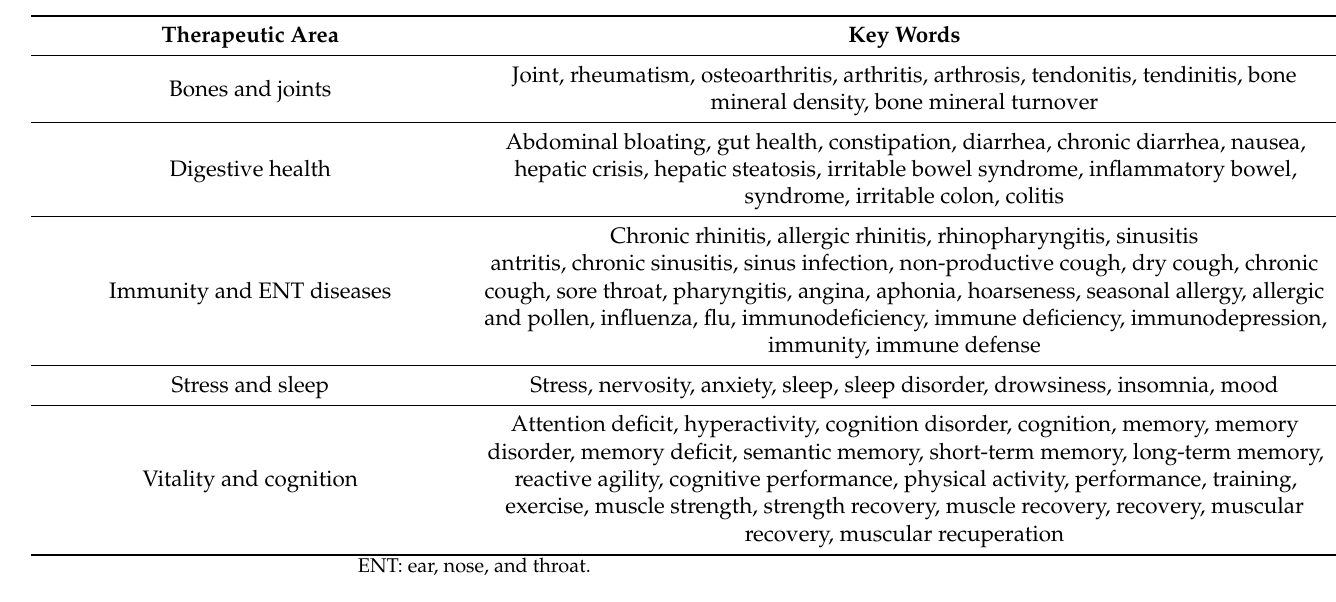
Table 1. Search terms/keywords used for PubMed literature search.